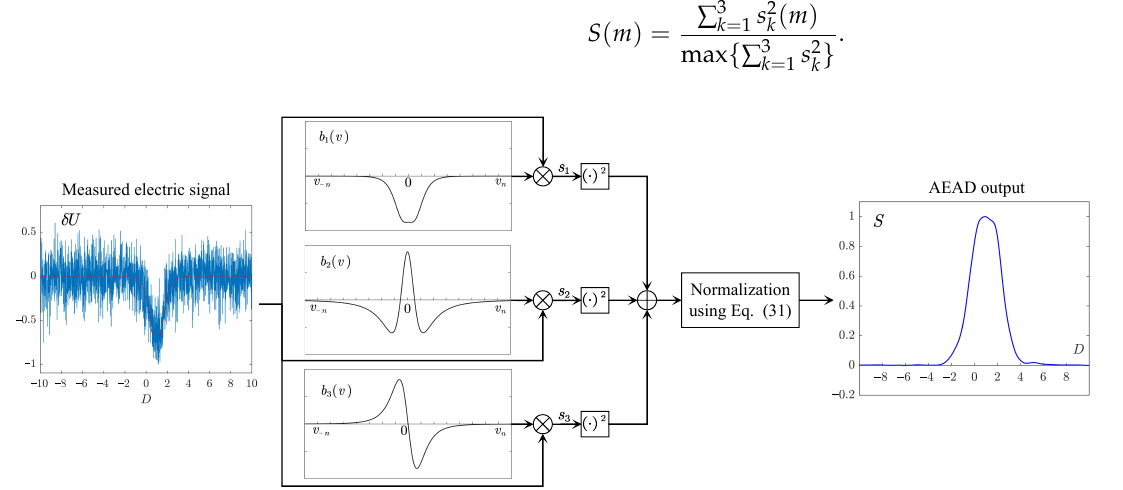
Figure 3. Diagram of AEAD OBF energy